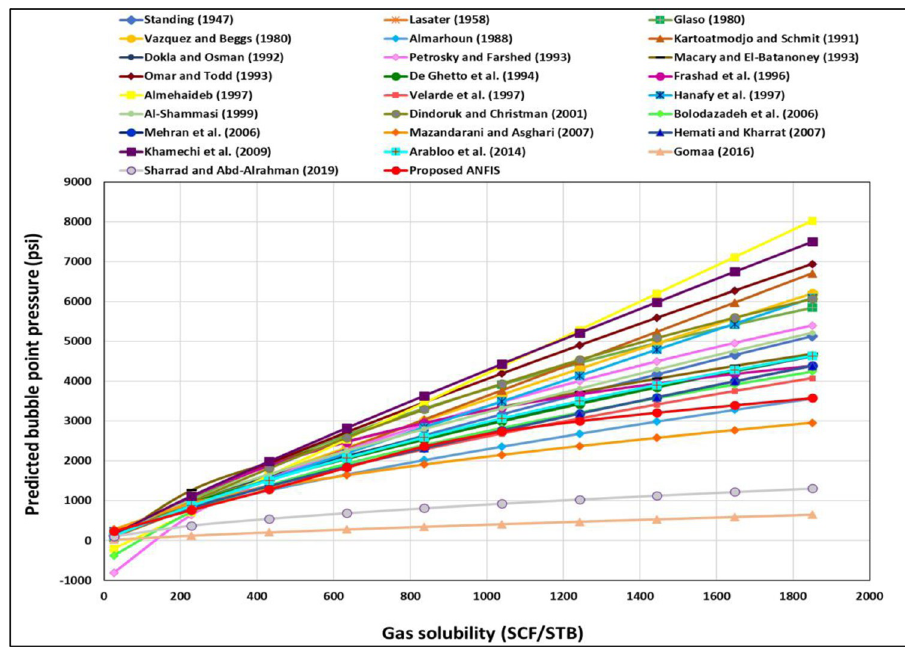
Fig 5. Rs TrA of the ANFIS and existing